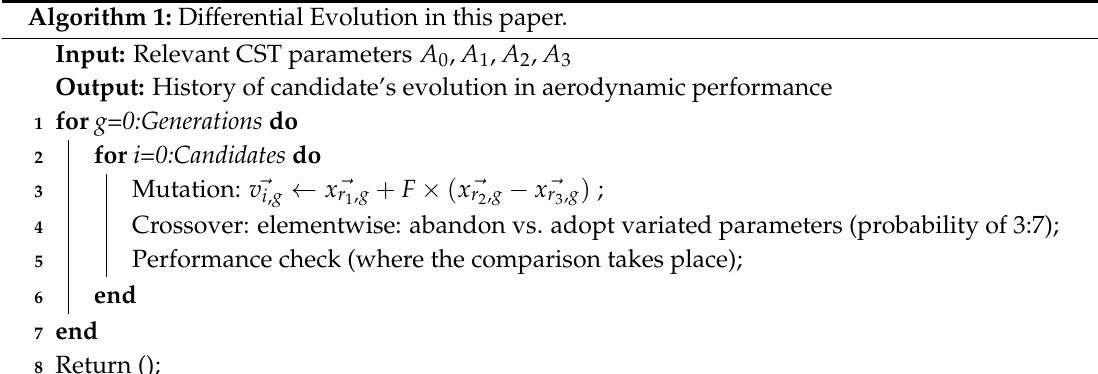
Algorithm 1: Differential Evolution in this